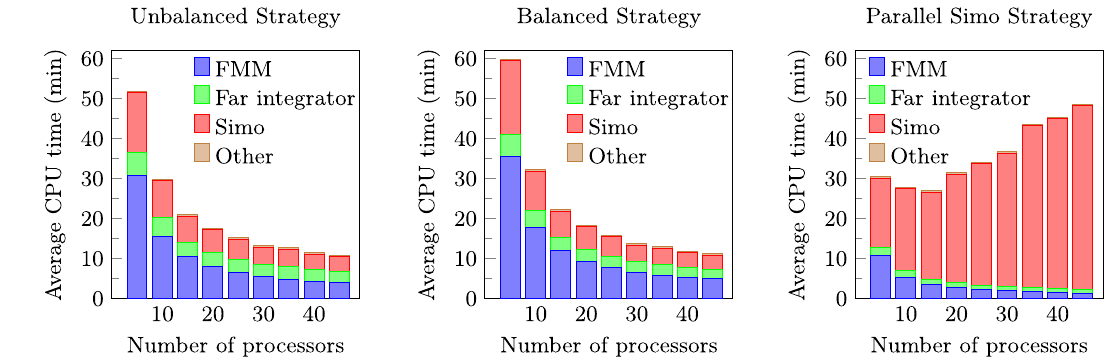
FIG. 6. Average CPU times of different subprocedures for PHAD parallelization strategies with 49 . 9 × 10 3 particles, FMM order 6, and clustering parameter q ¼ 60 . The unbalanced and balanced strategies show CPU times for five time steps and the parallel Simò strategy was ran for one time